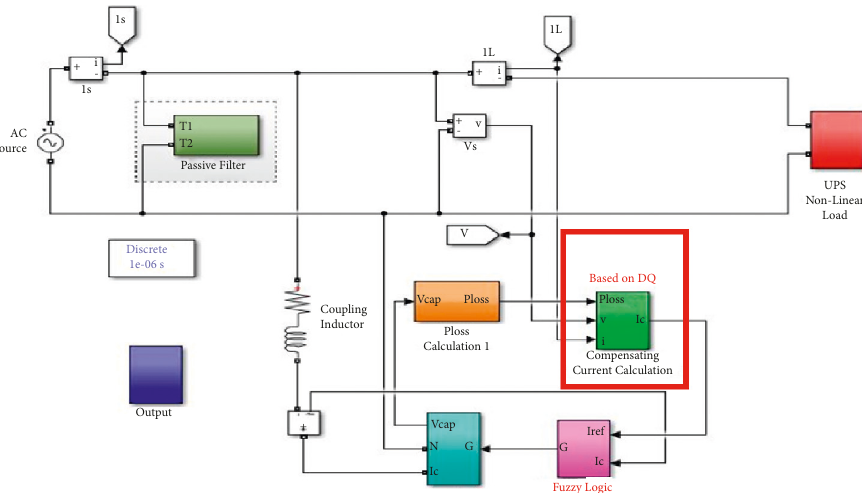
Figure 27: Simulation model of Single-phase Half-Bridge HAPF based on DQ Theory Reference Current Extraction (RCE) with Fuzzy Logic Current controller (FLCC) for the UPS System connected with nonlinear load.